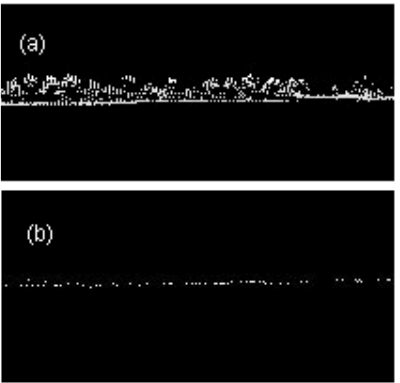
Figure 5. Section view of an urban area with vegetation. (a) before removing the vegetation influence (b) after removing the